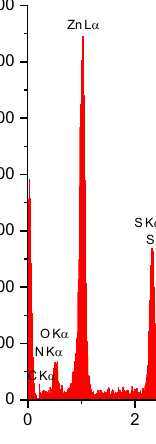
Figure 4. EDX Analysis of nanoporous Zn-MOF microspheres.